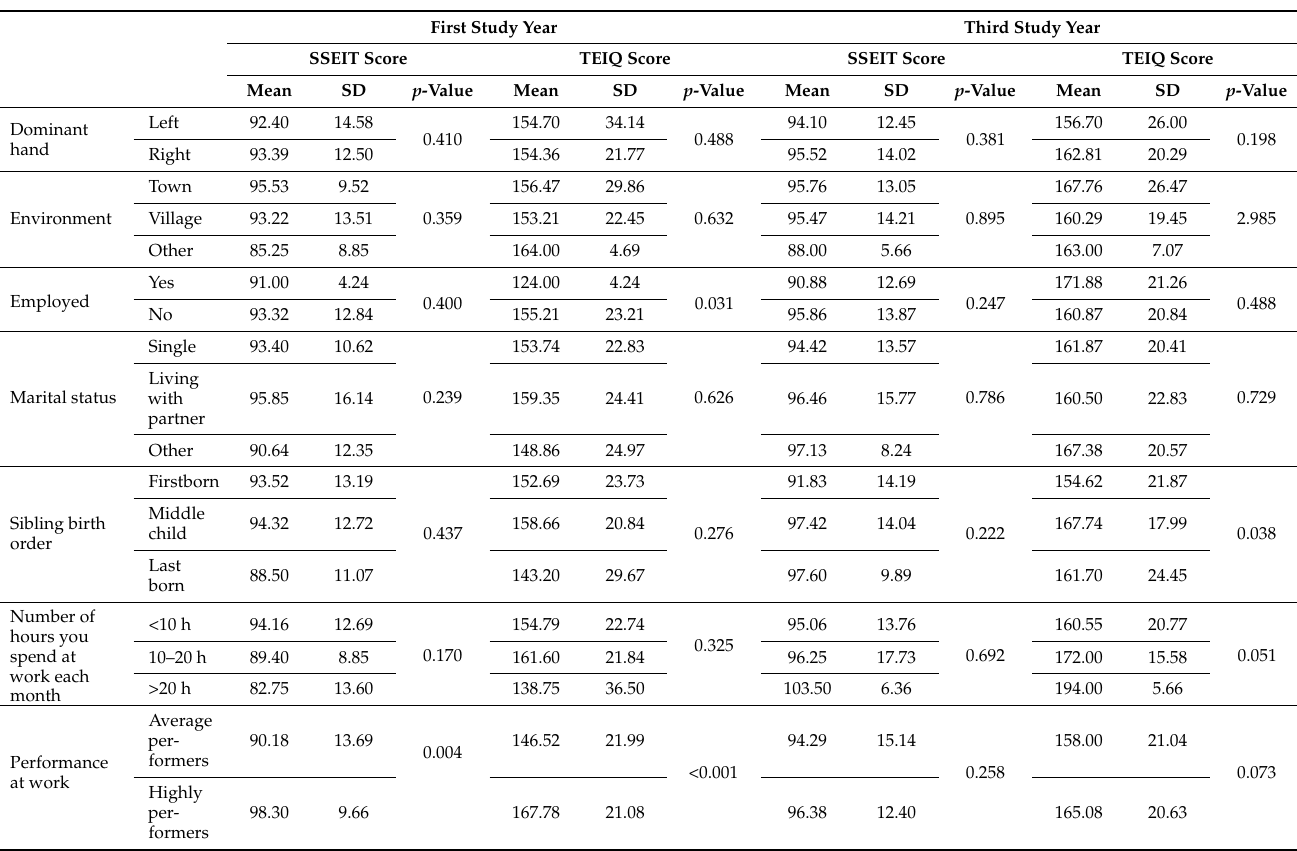
Table 2. Average SSEIT and TEIQ scores in the first and third year in relation to other